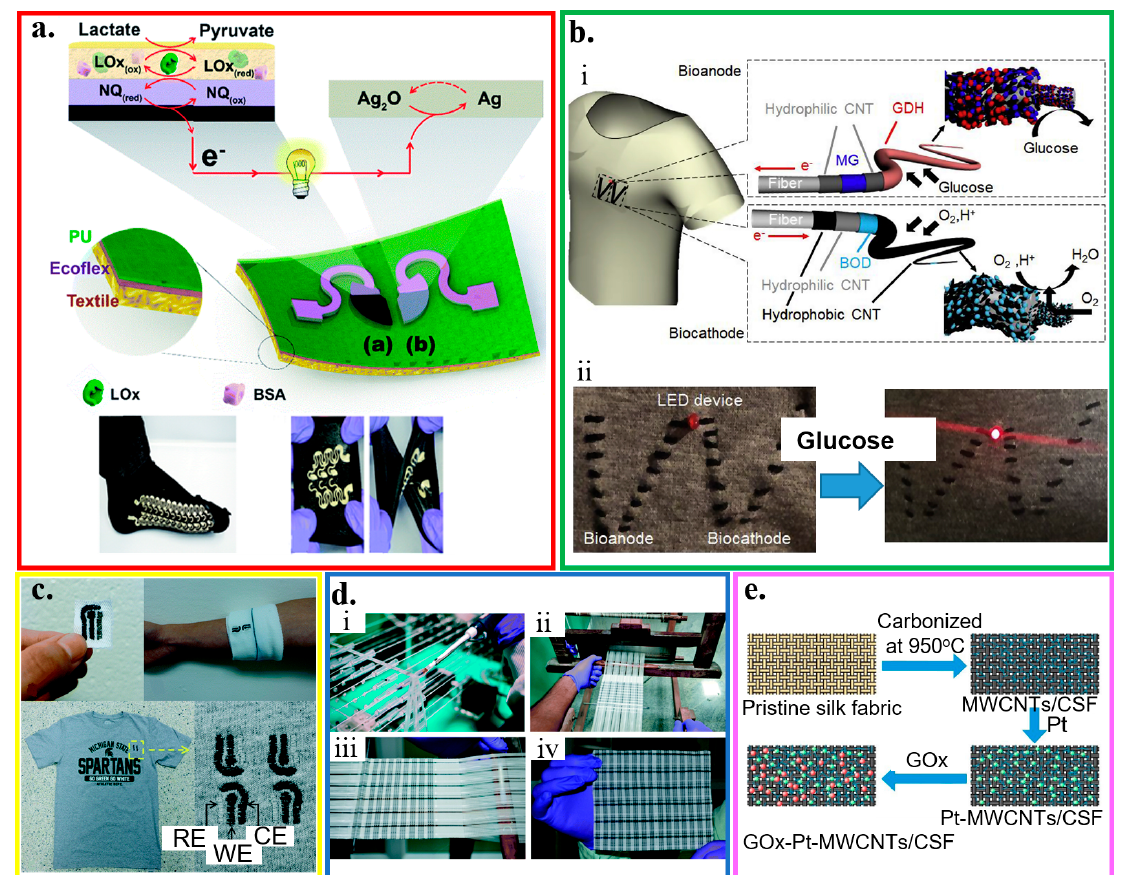
Figure 5. Fabric ‐ based electrochemical sensors. ( a ) Optical images of the designed stencil and its